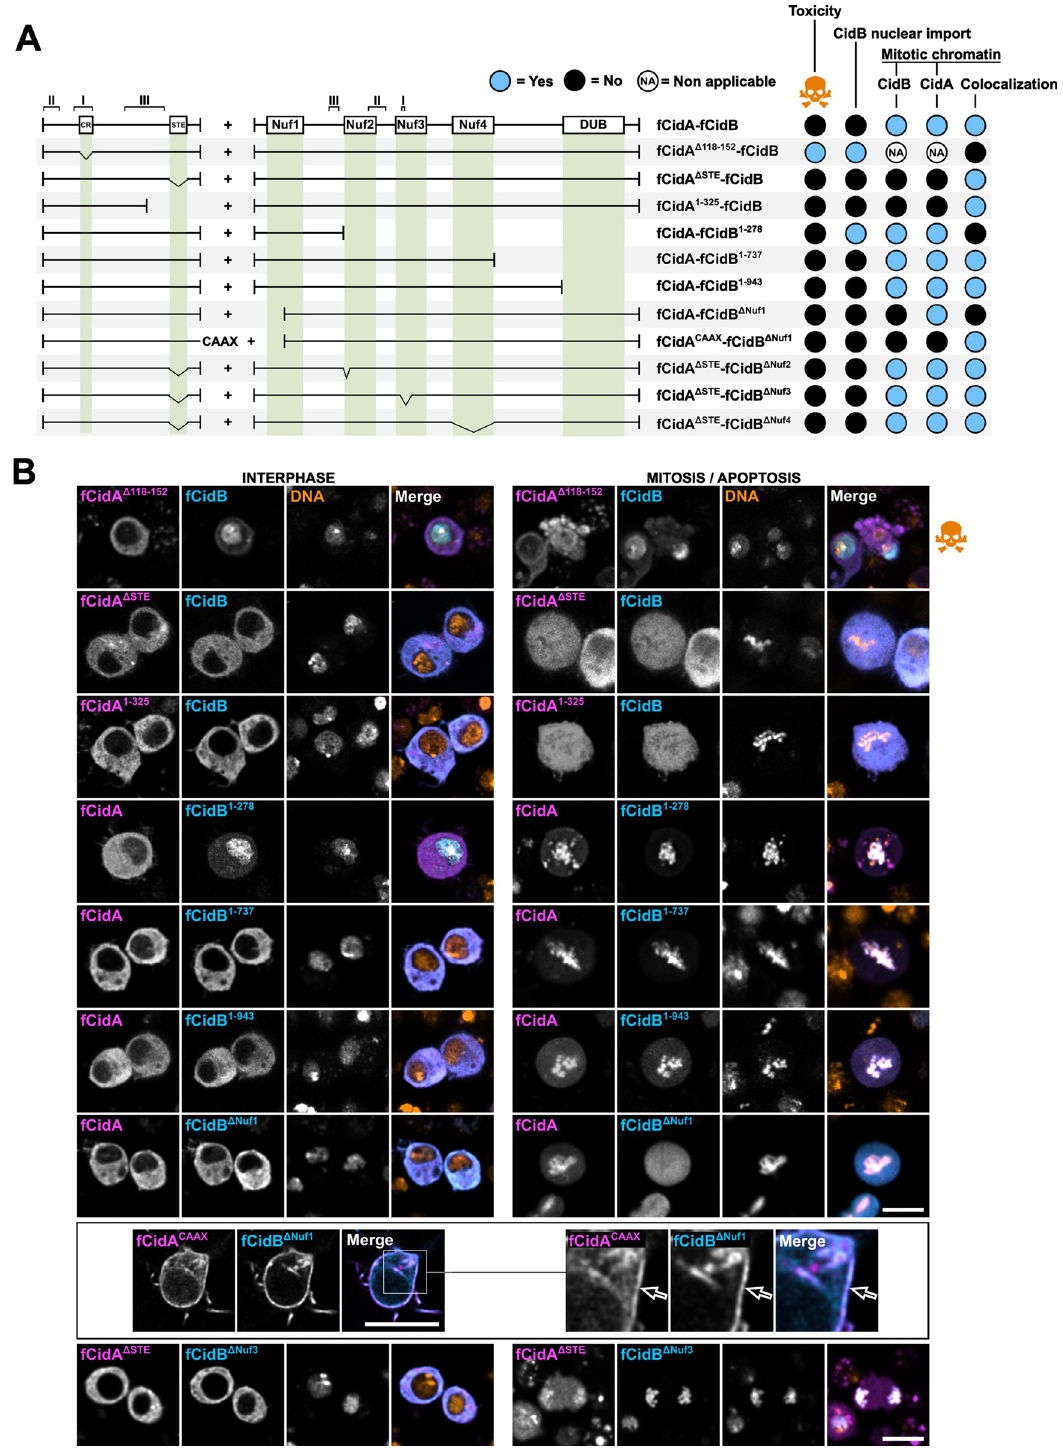
Fig 5. Phenotypes resulting from CidA-CidB mutants co-expression in cellulo . (A) Schematic drawing of fCidA and fCidB wild- type and mutant combinations co-expressed with the T2A self-cleaving peptide under the pAc5 promoter. The resulting phenotypes presented on the right include the toxicity (i.e. no mitosis and apoptotic events observed), the CidB nuclear import during interphase, and the CidA and CidB mitotic localizations (i.e. on the chromatin). (B) Confocal images of cells expressing the constructs presented in (A) in interphase and mitosis or apoptosis -skull and crossbones symbol-. Images of CidB Δ Nuf1 - CidA